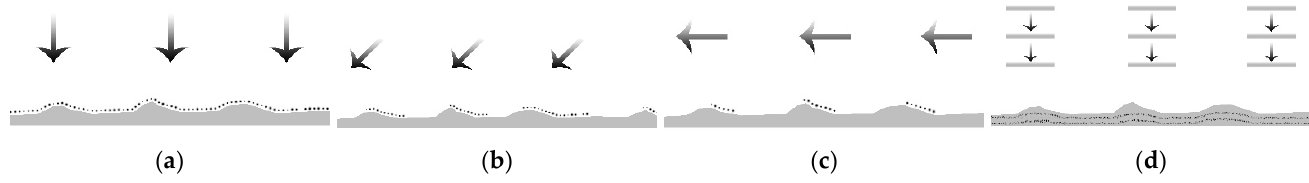
Figure 5. Methods of color applications: ( a ) perpendicular airbrushing; ( b ) oblique airbrushing; ( c ) parallel airbrushing;